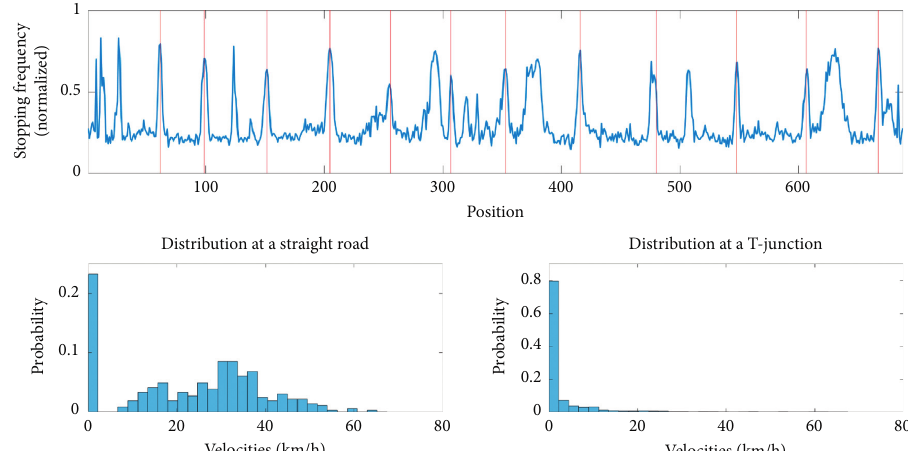
Figure 16: Graphs of normalized stopping frequency, i.e., probability of bus stopping at each position along the bus route, and velocity distributions of two different positions on the road. These graphs are derived from the raw data collected over 13 weeks. Red lines on the graph are the sites where there are bus